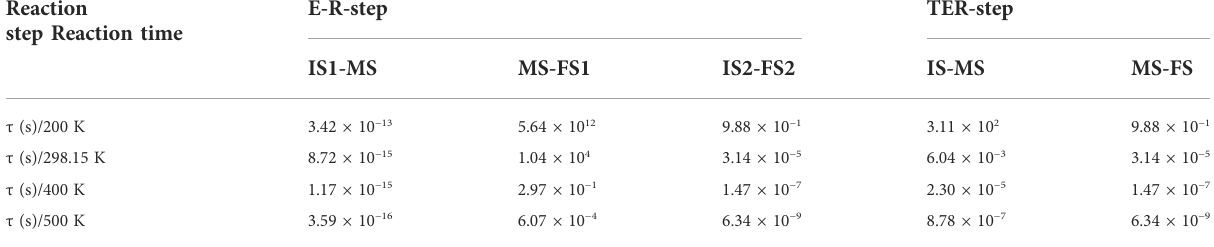
TABLE 3 Time required for each step of the reaction path in E-R and TER reaction at 200 K, 298.15 K, 400 K, 500 K. Reaction step Reaction